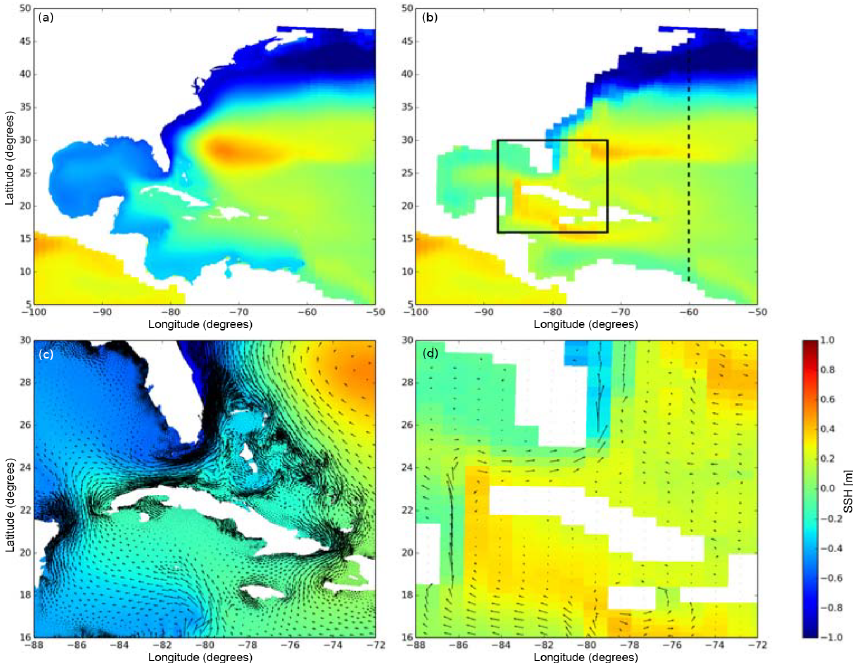
Figure 18. Sea surface heights and velocities of a ADCIRC run embedded in a global circulation POP model. Top panels show the sea surface height (SSH) of a region covering the western North Atlantic Ocean, Caribbean Sea and Gulf of Mexico. Panel (a) shows the high-resolution ADCIRC SSH field (superimposed on the POP field) and panel (b) the low-resolution POP field. The black square indicated in (b) is shown in more detail in (c) and (d) , where the SSH with velocities superimposed are shown (in the case of ADCIRC the barotropic velocities are shown, for POP the are the surface velocities). The dashed line in (b) is the open-ocean boundary of the regional ADCIRC